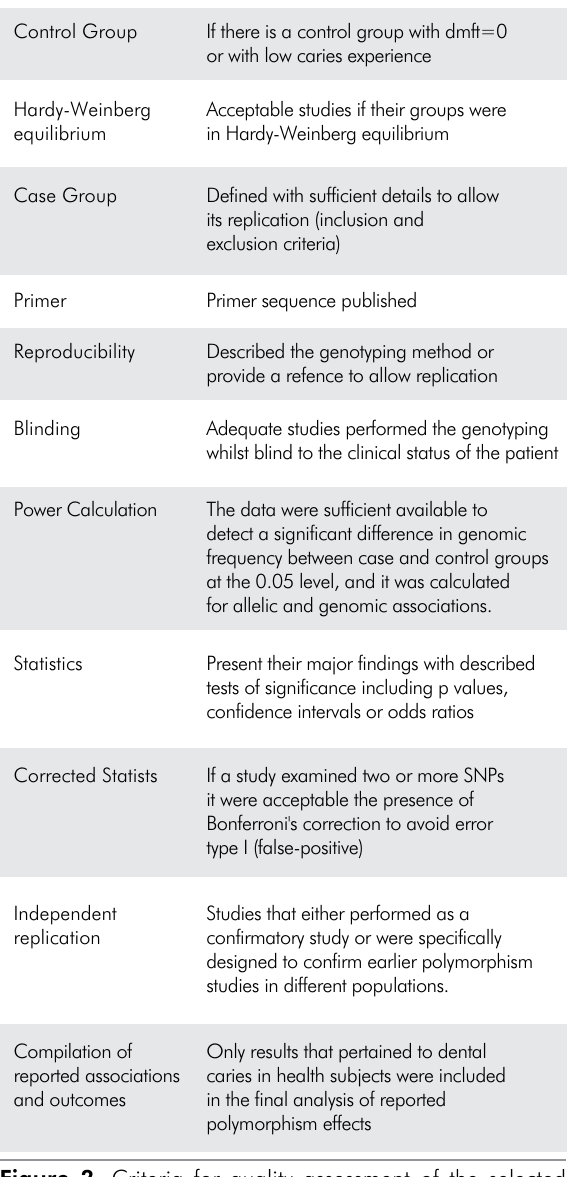
Figure 2. Criteria for quality assessment of the selected articles, adapted from 17